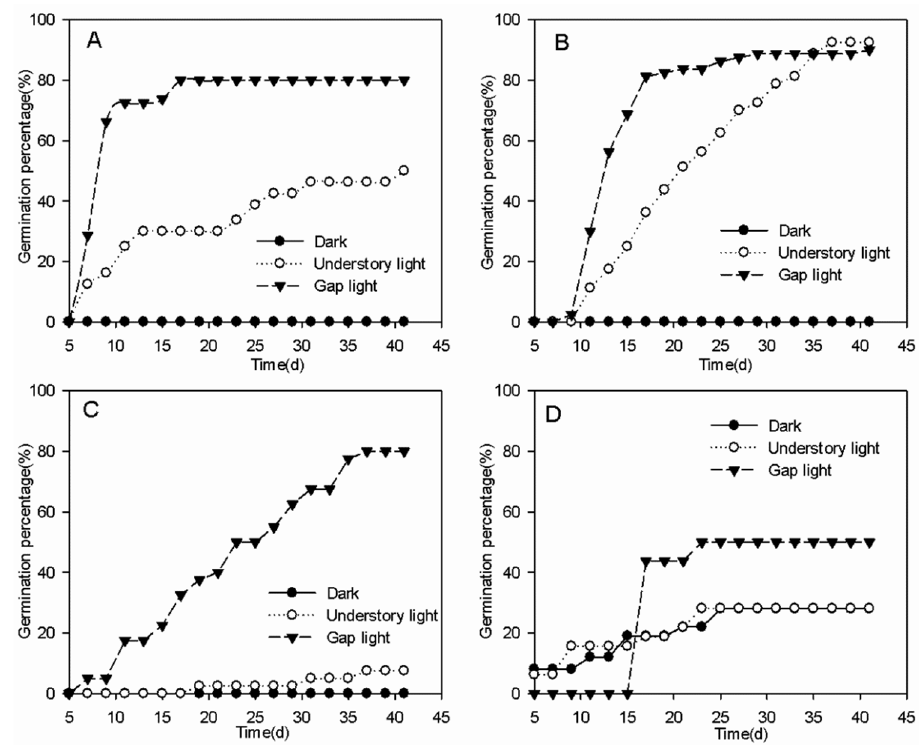
Figure 7. Effect of light intensity on seed germination of species with different ecological forms. Germination curves of ( A ) Thysanolaena maxima , ( B ) Melastoma sanguineum , ( C ) Trema tomentosa , and ( D ) Cryptocarya chinensis under different light intensities.